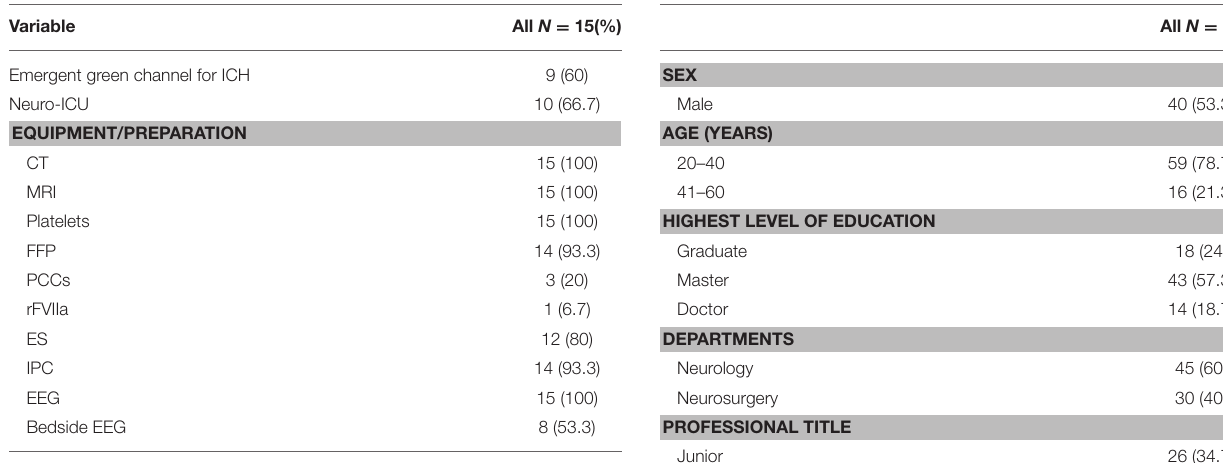
TABLE 4 | Characteristics of doctor questionnaire